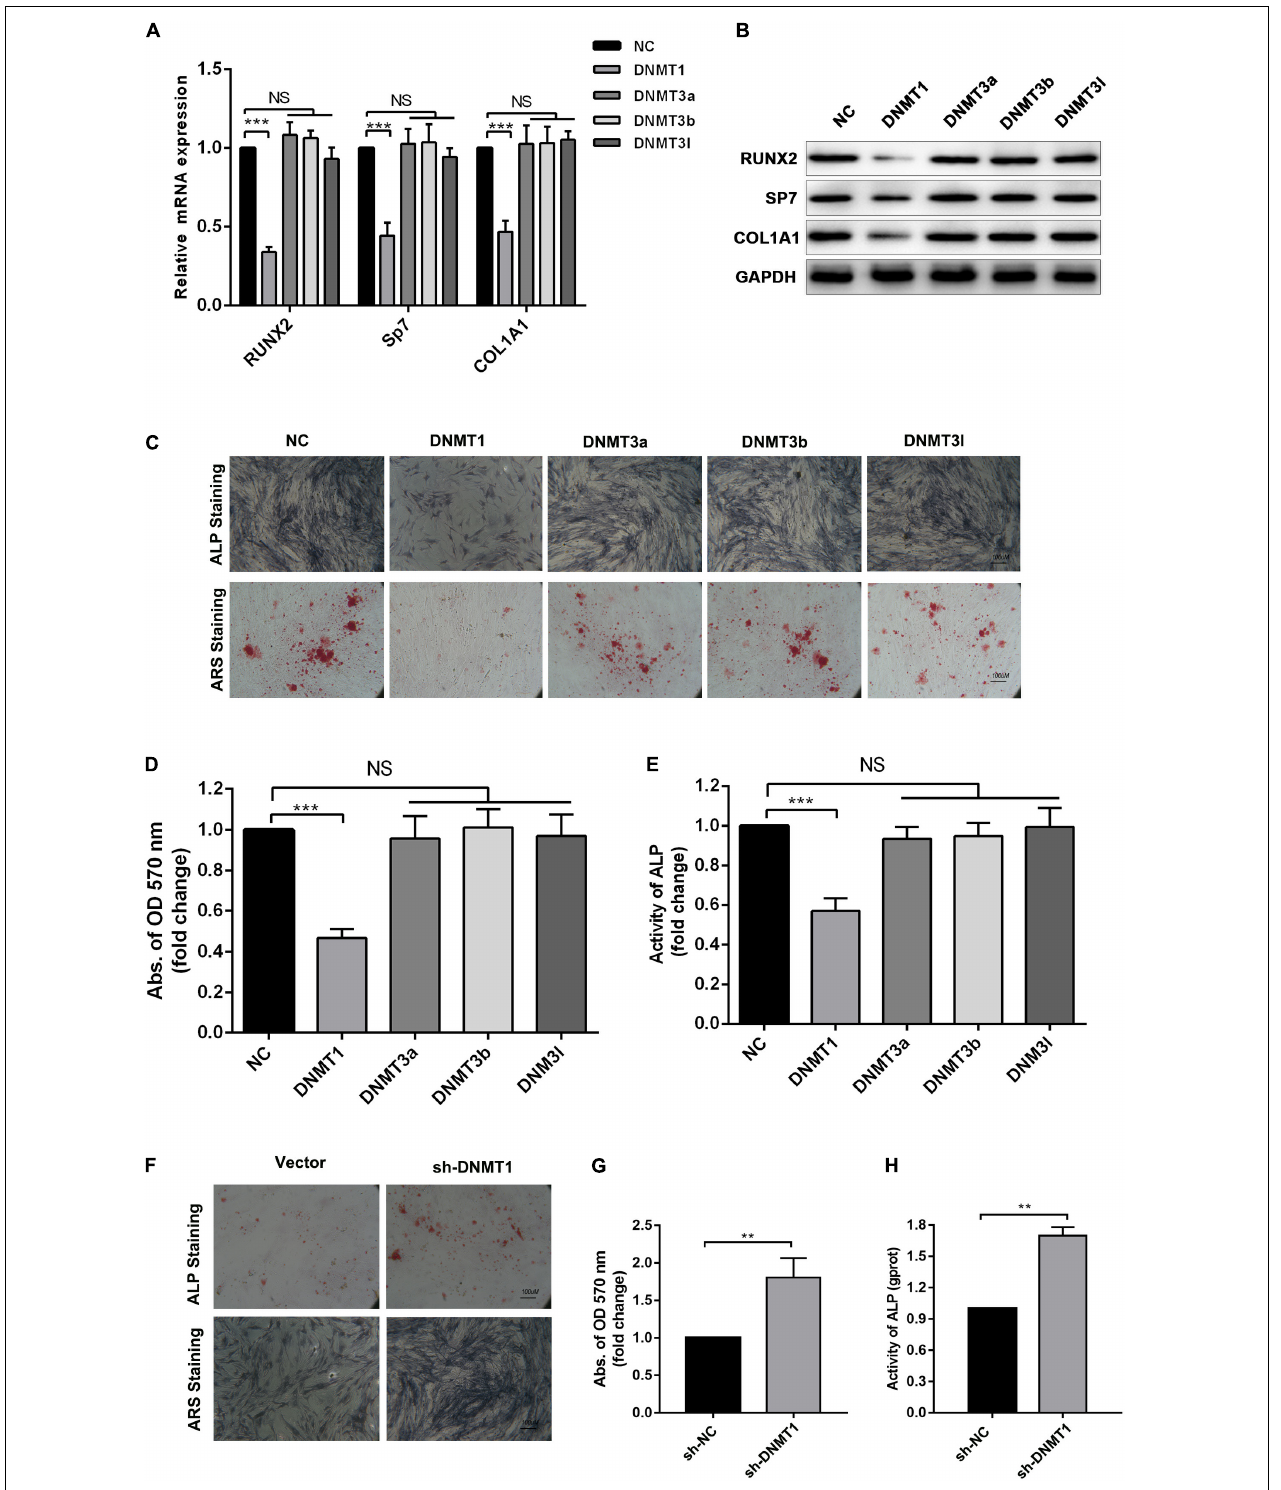
FIGURE 4 | (A,B) Expression of RUNX2, SP7 and COL1A1 4 in DNMT1, DNMT3A, DNMT3B, DNMT3L overexpressed hADSCs were determined by Western blot and RT-qPCR. (C–E) hADSCs were transfected with DNMTs plasmid and cultured in osteogenic differentiation medium for 14 days, Alizarin red staining and ALP staining showed mineralized nodule formation, ALP activity and quantification of Alizarin red staining by spectrophotometry were determined. (F–H) DNMT1 silenced hADSCs were cultured in osteogenic differentiation medium for 14 days, Alizarin red staining and ALP staining showed mineralized nodule formation, ALP activity and quantification of Alizarin red staining by spectrophotometry were determined. Data are shown as means ± SD. ** p < 0.01, *** p < 0.001.